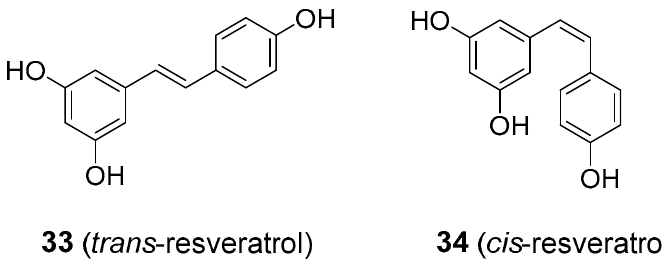
Figure 8. Resveratrol exists as cis- and trans-isomers, the trans- form being prevalent in nature. No significant difference in biological activity was observed between the two [103].